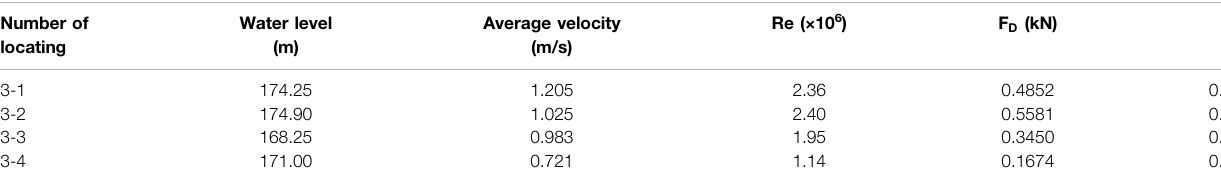
TABLE 3 | The calculation of drag coef fi cient in wharf fi